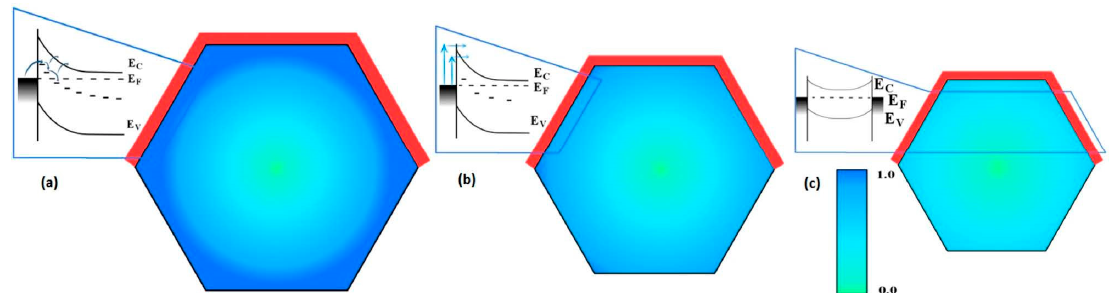
Figure 9. Schematic diagrams of band bending at Pt-ZnO nano/microwire contact for ( a ) 900 nm, ( b ) 600 nm, and ( c ) 400 nm diameter wires linked to the interfaces of their corresponding wires. Darker shading signifies higher acceptor density and defect-assisted hopping with increasing radius. With decreasing diameter, interface acceptor density decreases and contact behavior changes from transport by ( a ) trap-assisted tunneling to ( b ) Schottky rectification to ( c ) blocking regions extending radially from multiple faceted surfaces can almost fully deplete the 400 nm diameter nanowire. With permission from [18]. Copyright 2018 American Chemical Society.